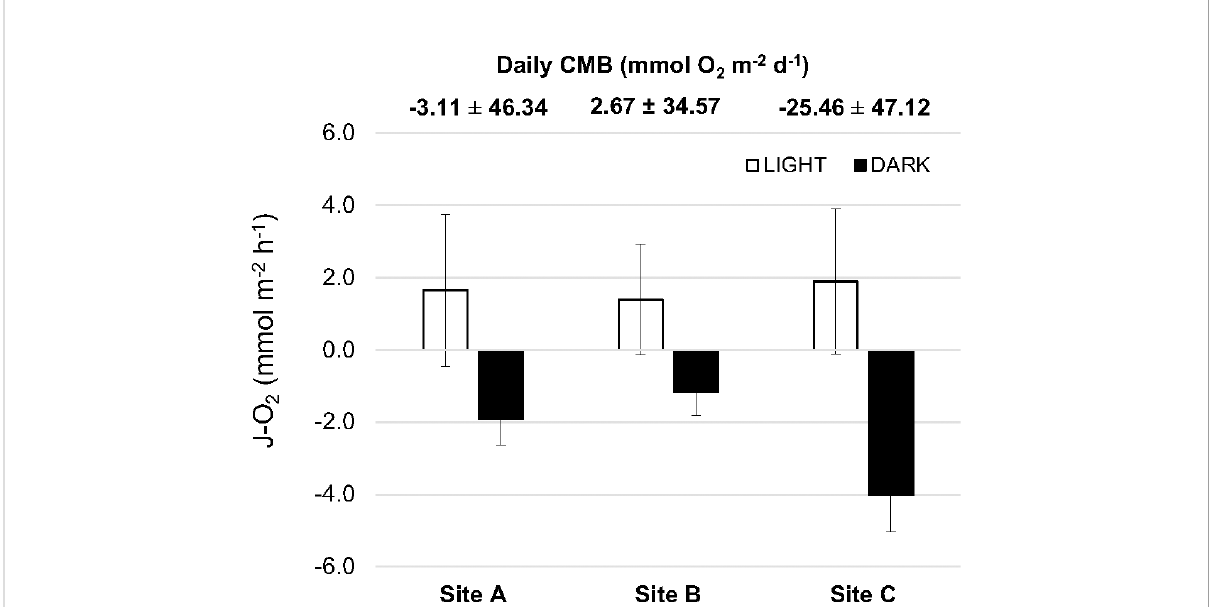
FIGURE 5 Community metabolic fl uxes of oxygen measured in light (white columns) and dark (black columns) conditions. Positive rates mean net release from the community to the water column whereas negative values represent net consumption rates from the benthic community. Bars are mean ± SEM. Numbers above indicate the daily benthic community metabolic balance (CMB) (mean ± SD) for each site.